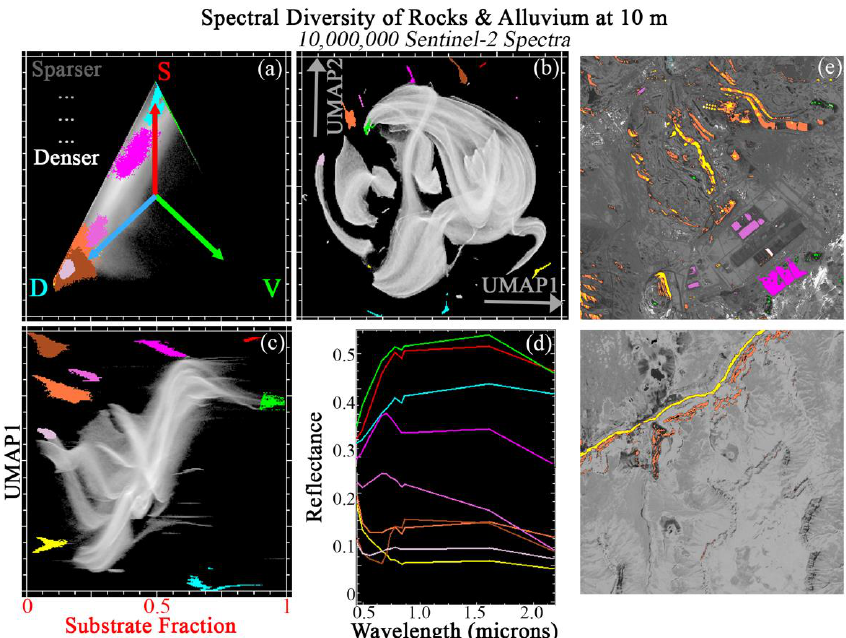
Figure 13. Joint characterization of rocks and alluvium (1). 10 × 1 megapixel Sentinel-2 tile subsets are selected from global geology hotspots and analyzed at full 10 m pixel resolution. These spectra preferentially occupy the S to D apexes of the SVD mixing space ( a ), leaving the V portion of the space relatively sparse. The global 3-endmember linear mixture model fits these spectra less well than the agricultural spectra (here, only 96% of spectra with <5% RMSE). UMAP ( b ) captures both subtle mixing continua and discrete clusters, but does not offer physical interpretability. Joint characterization ( c ) uses the physical meaning of the Substrate mixture fraction to contextualize the subtle statistical relationships captured by UMAP. Example regions of interest are identified from the joint space and projected onto the ternary mixing and UMAP spaces. Mean spectra for each region ( d ) illustrate similarities and differences among statistically distinct clusters. Clusters identified by joint characterization also frequently show geographic coherence ( e ).